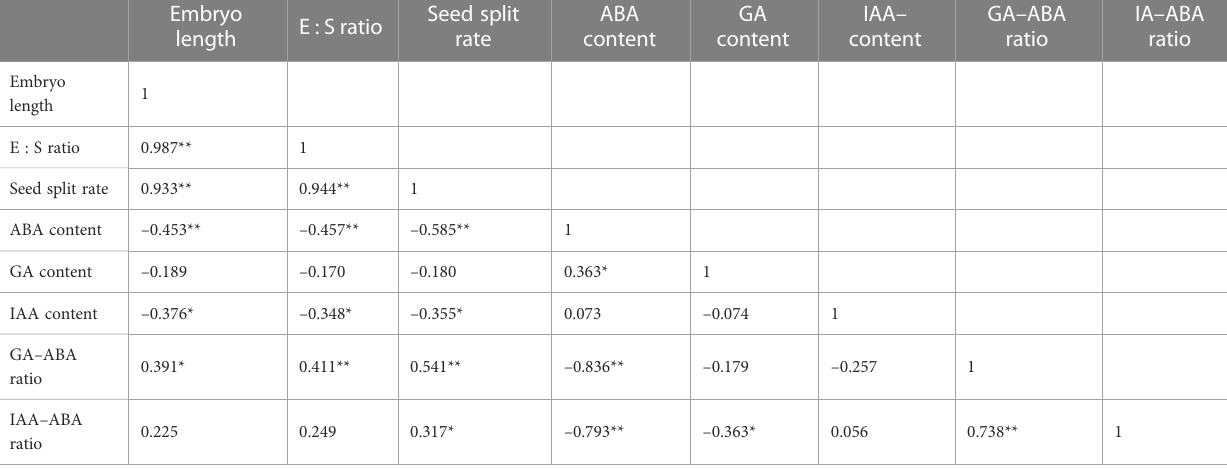
TABLE 2 Correlation analysis of the embryo growth and endogenous hormones in Taxus chinensis var. mairei seeds.